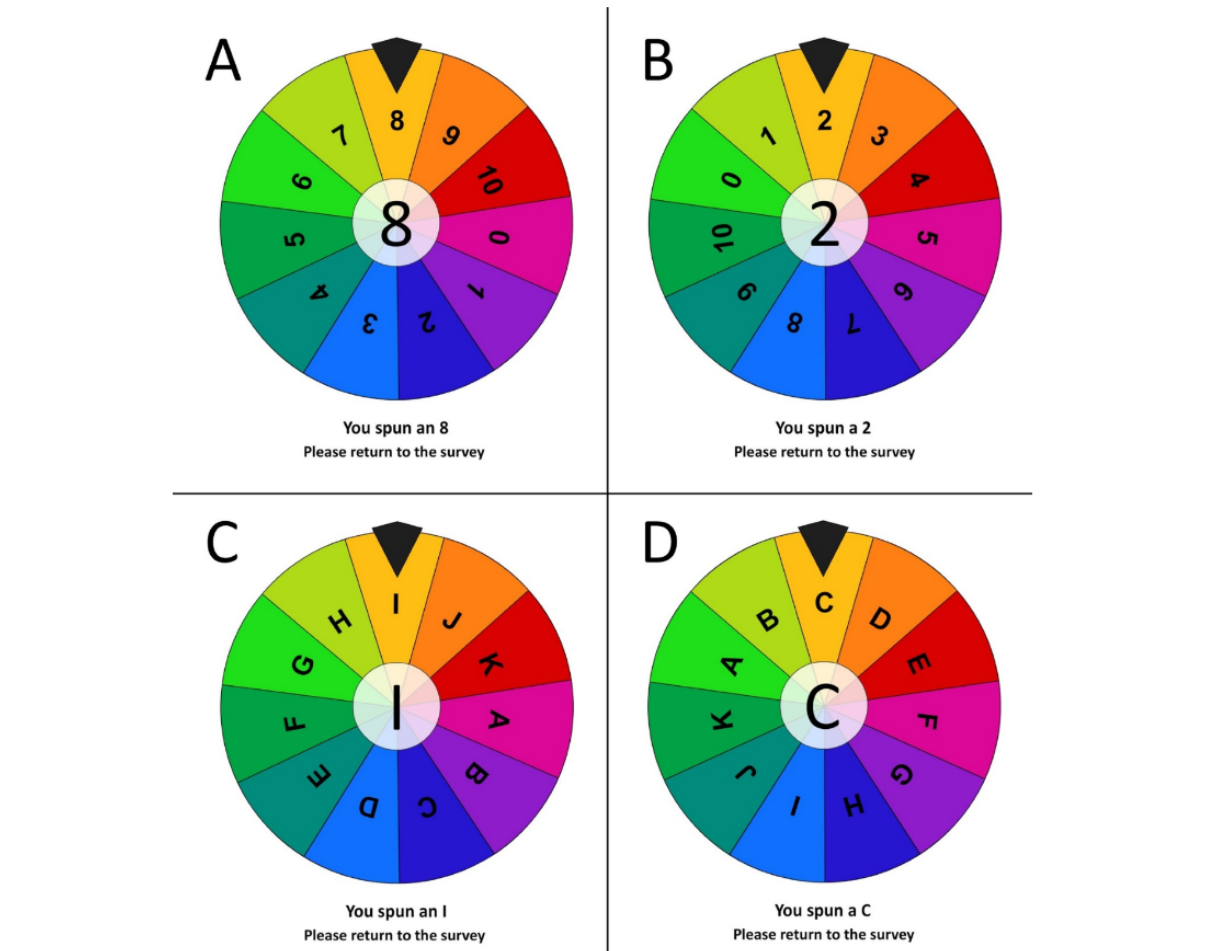
Figure 2. Spinning wheels used for group 1 (A), group 2 (B), and group 3 (C and